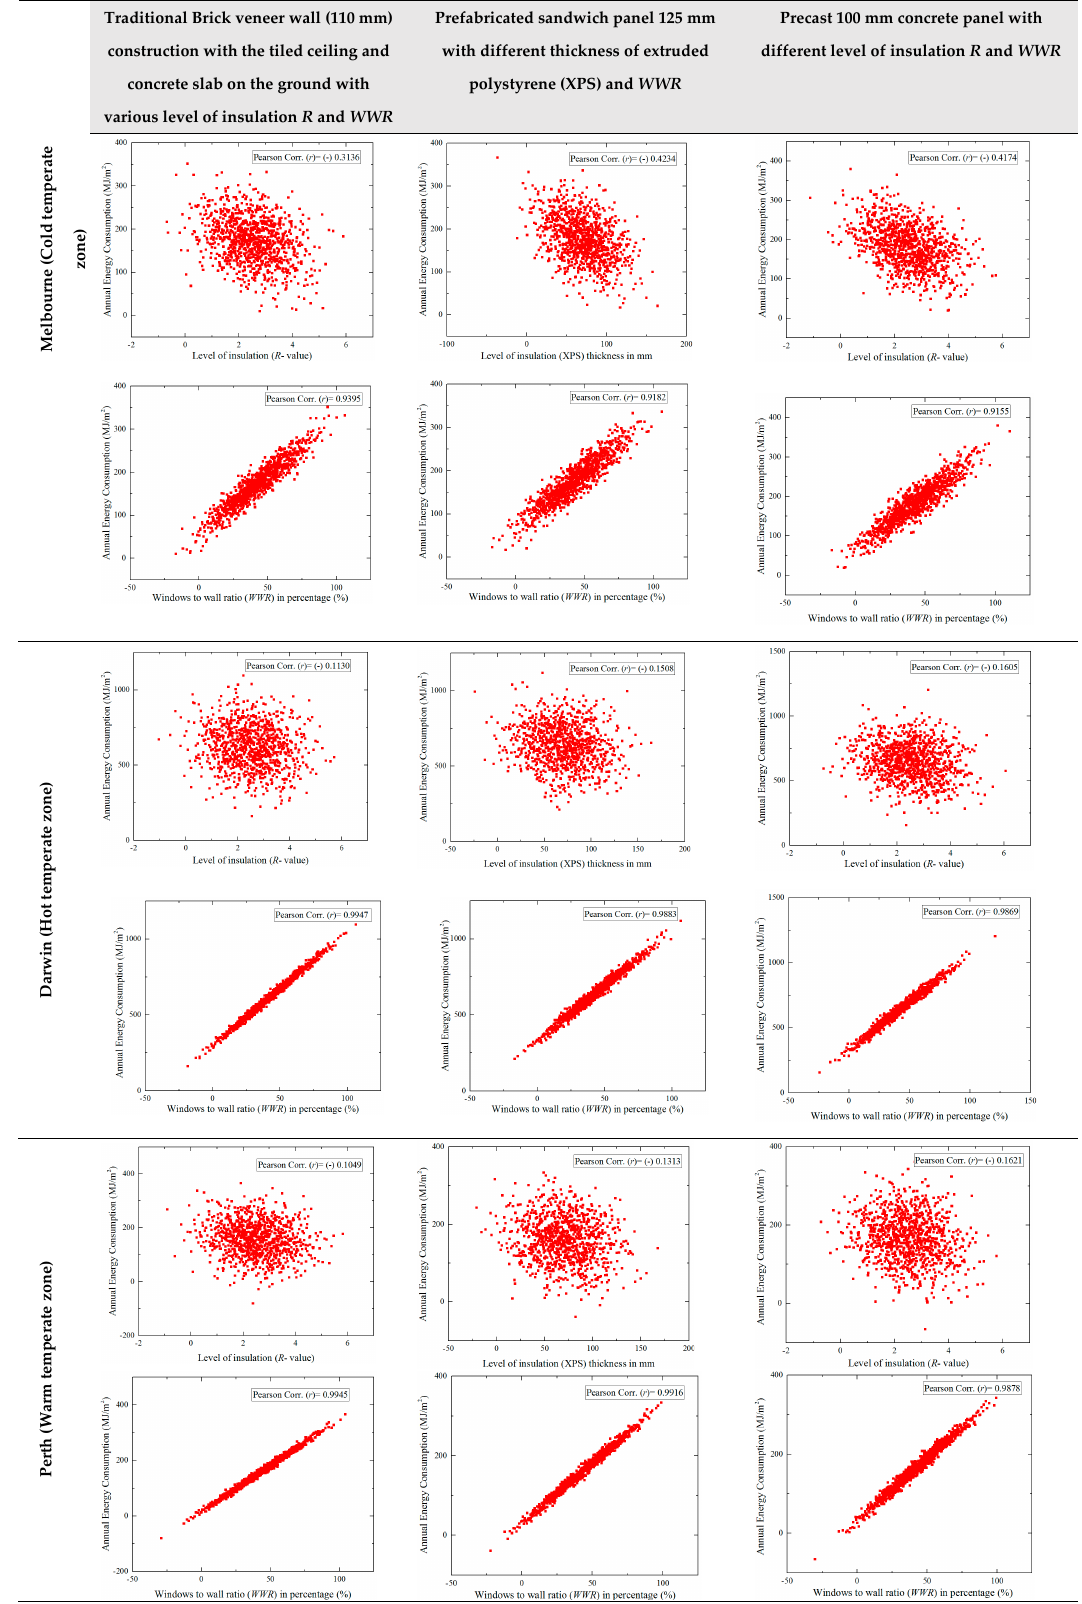
Figure 5. Scatter plots for energy consumption vs. design variables ( R, WWR ).